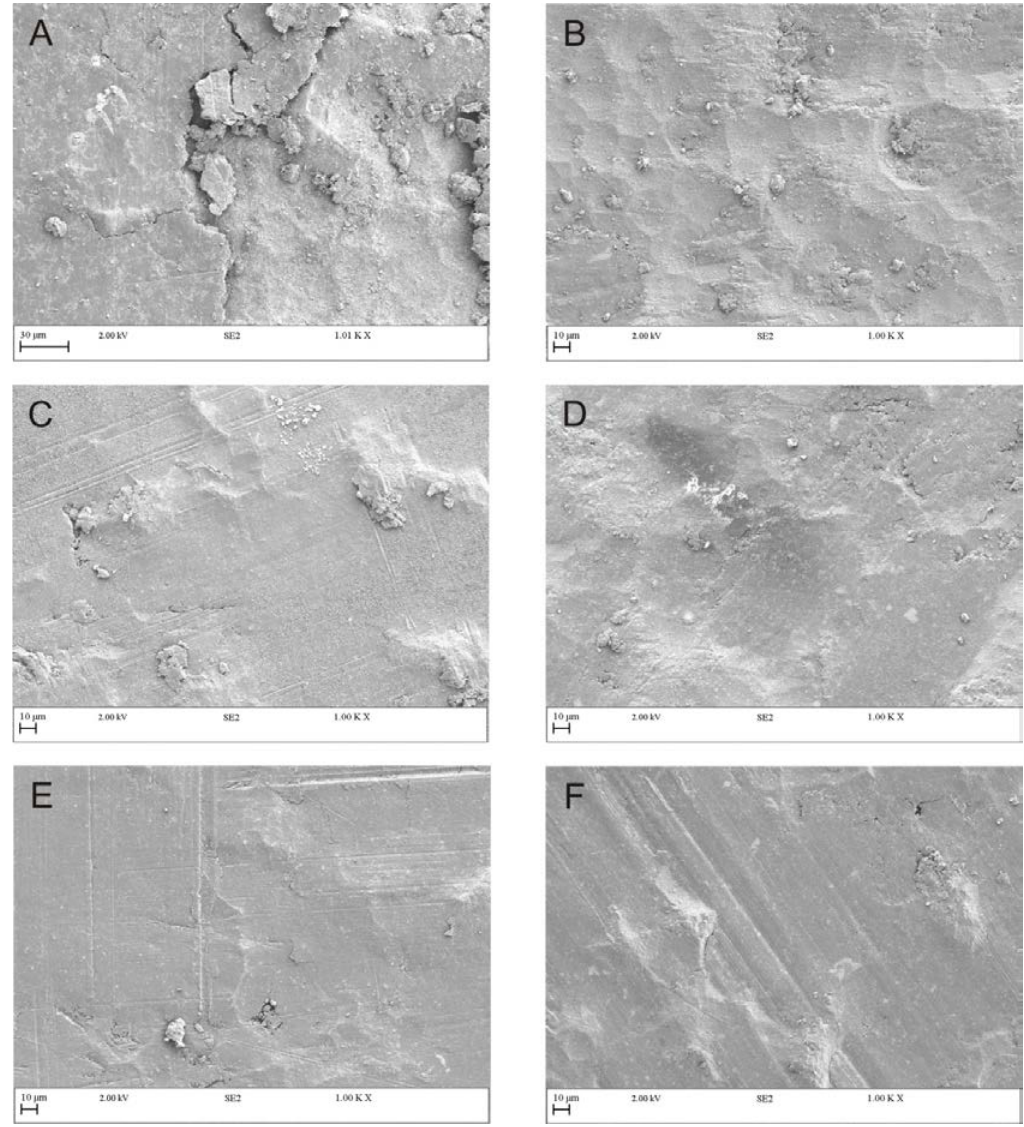
Figure S6. SEM images of different PDEs fabricated using different batches of HB pencils (boxes 1 to 6) on plastic substrates: PDE1 ( A ), PDE2 ( B ), PDE3 ( C ), PDE4 ( D ), PDE5 ( E ) and PDE6 ( F ), respectively.